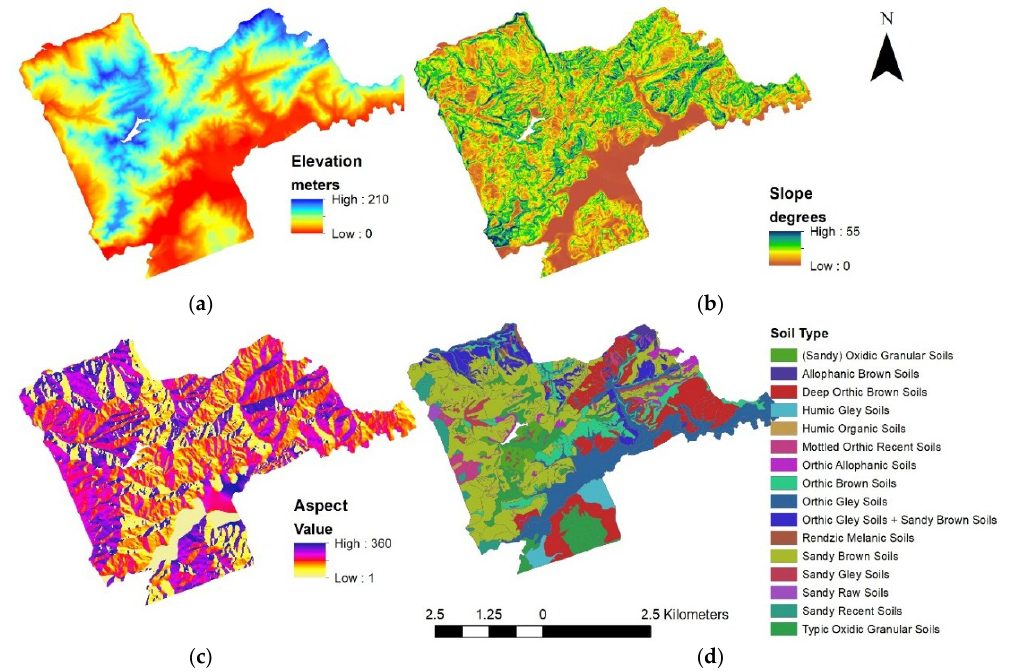
Figure 2. Topographic and soil variables used in this study: ( a ) elevation ( b ) slope angle ( c ) slope aspect ( d ) soil types of the Limestone Downs area.